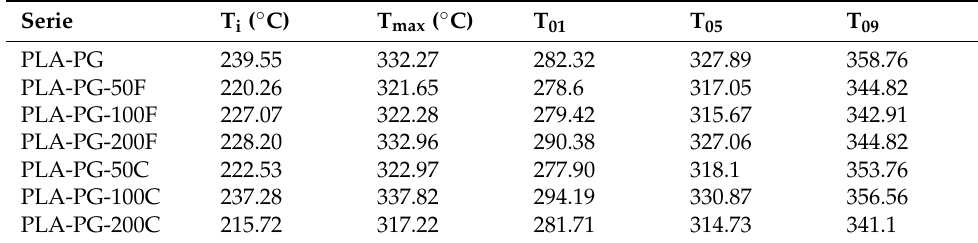
Table 2. Data obtained from the DTG curve for the films